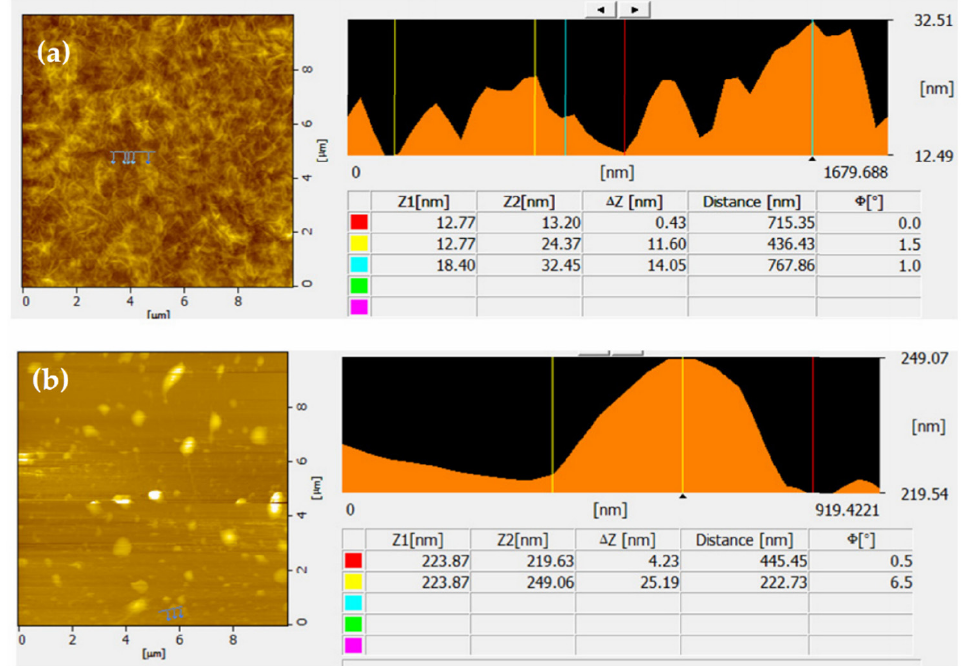
Figure 9. Characterization atomic force microscopy images of ( a ) graphene oxide and ( b ) bacterially reduced graphene oxide [163] (CC BY).